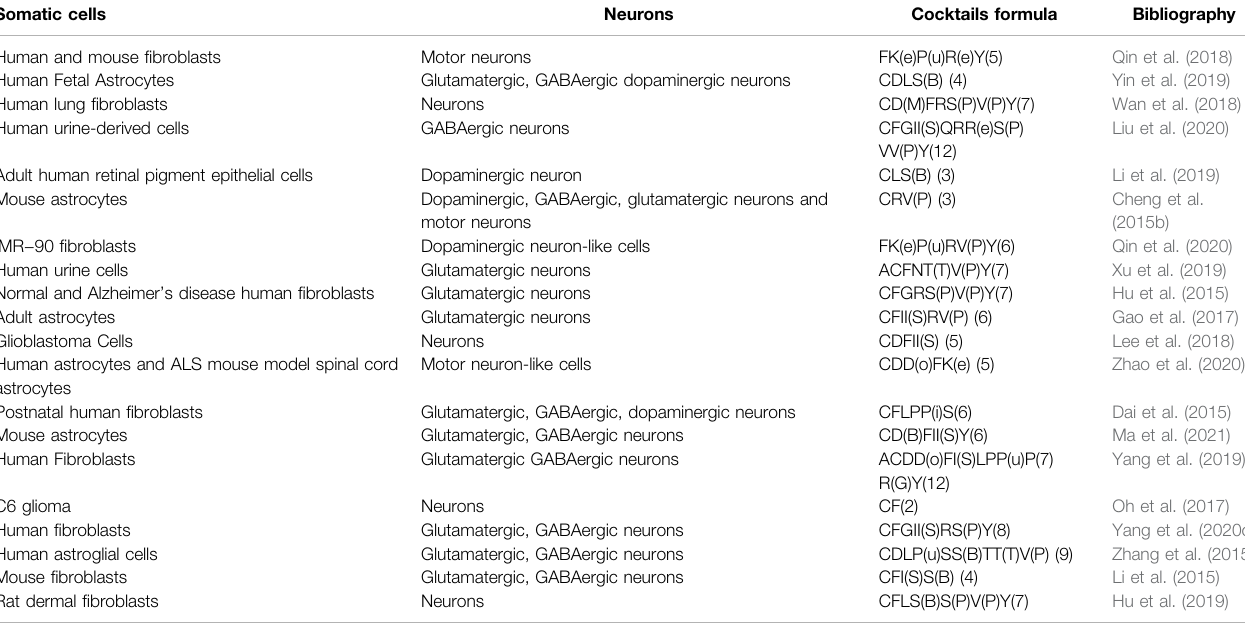
TABLE 2 | Small molecule cocktail formulas in direct neuronal reprogramming. Somatic